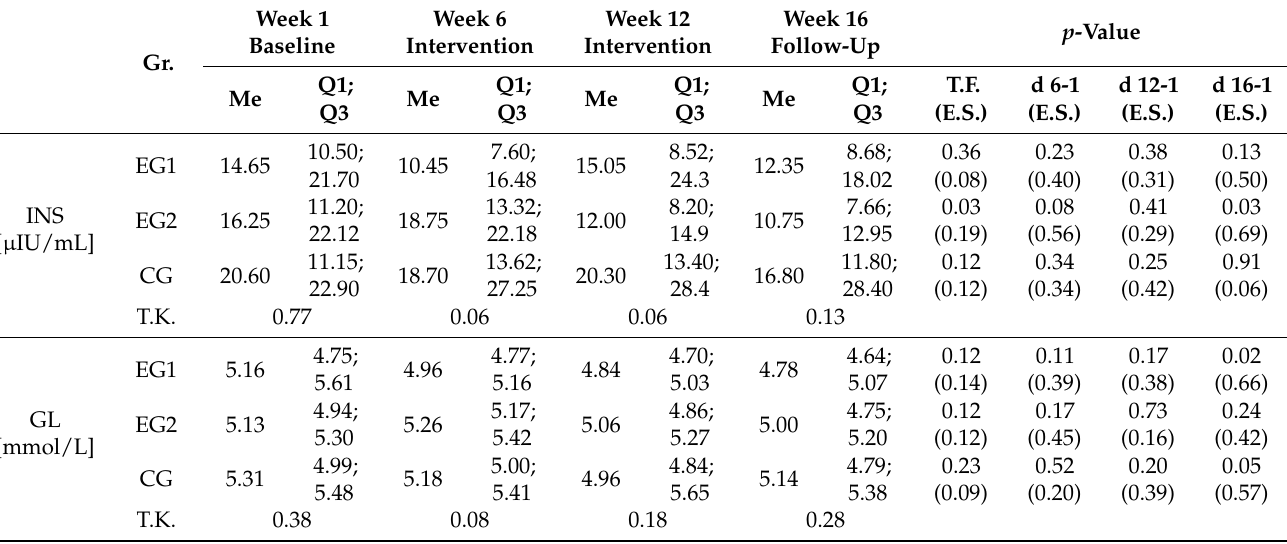
Table 5. Concentrations of glucose (GL) and insulin (INS) in participants’ blood in the aerobic